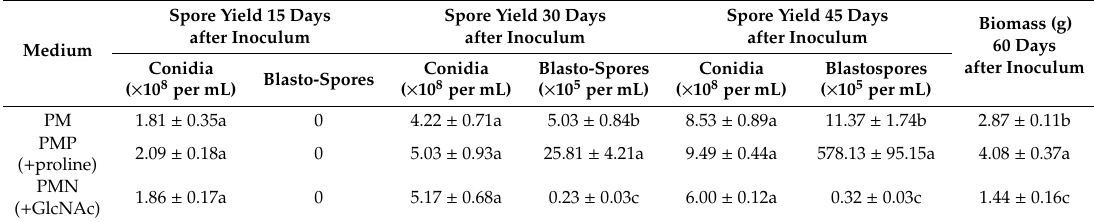
Table 1. Effect of L-proline and N-acetylglucosamine on biomass accumulation of O. sinensis .